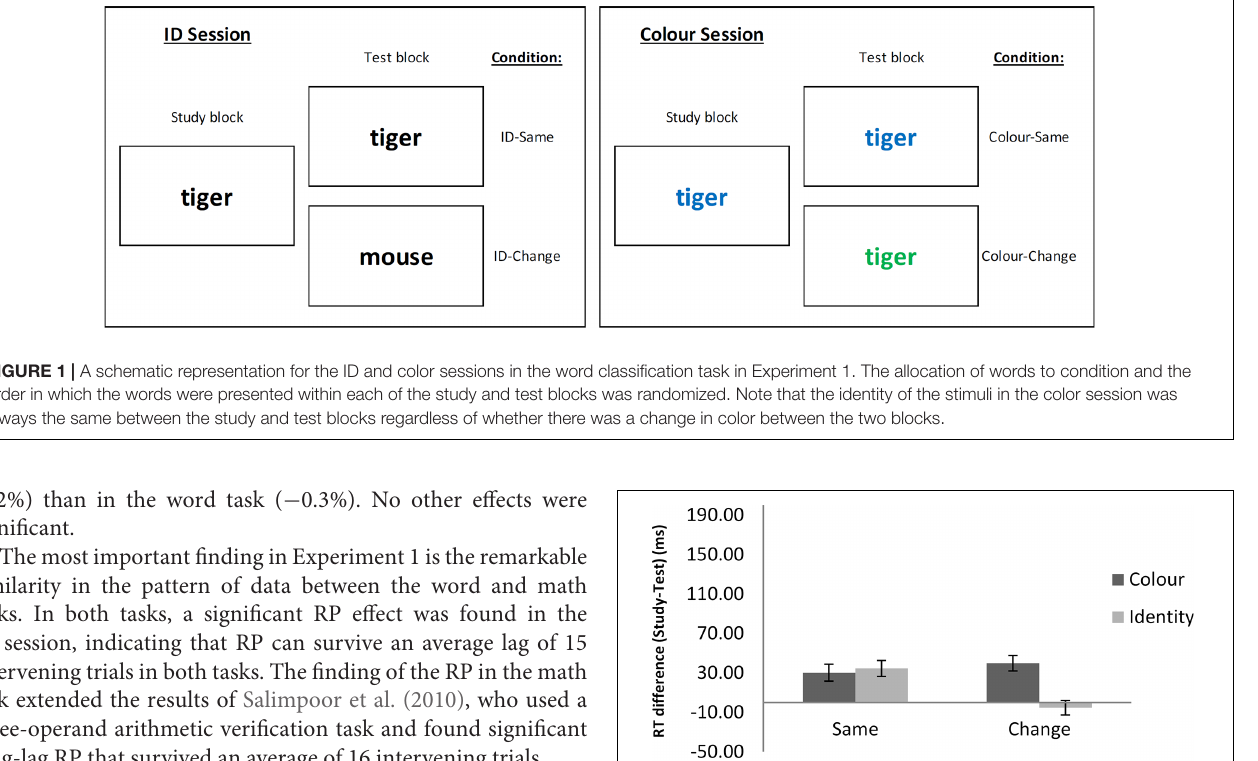
FIGURE 2 | RT differences between the study and test blocks in the word classification task as a function of feature and condition in Experiment 1. Error bars show ± 1 standard deviation of the mean. A positive number indicates faster RT in the test block than in the study block. A negative number indicates slower RT in the test block than in the study block.